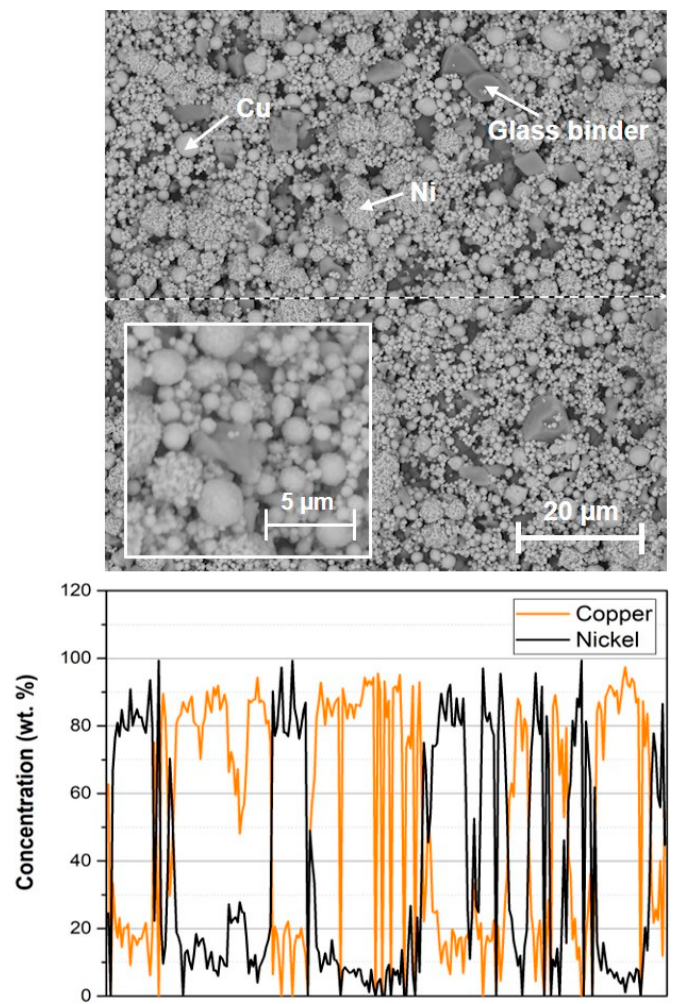
Figure 5. SEM image of dried copper-nickel thick film paste and EDS analysis of element distribution (dashed line represents the area where the EDS line scan was done).